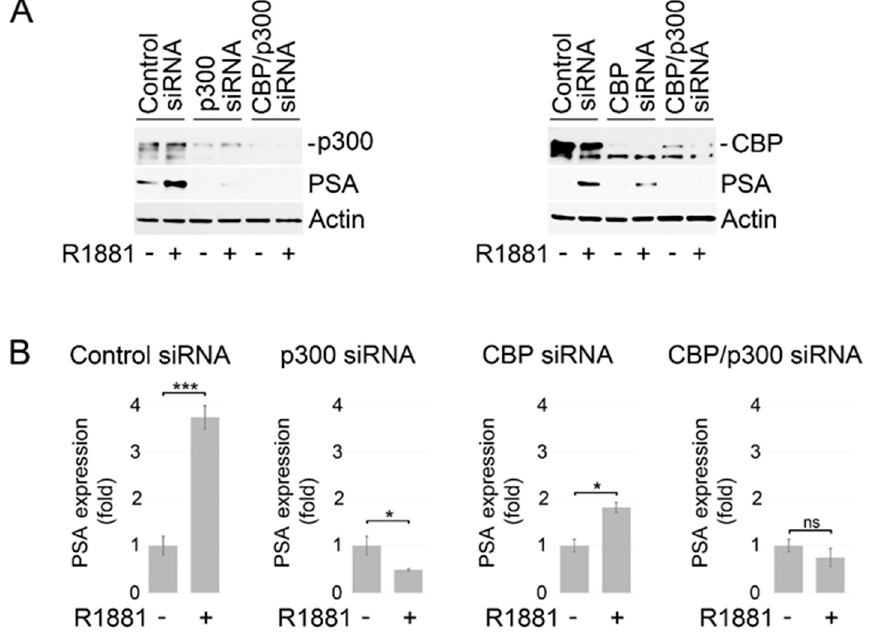
Figure 3. Knockdown of p300 and CBP inhibits AR signaling. ( A ) Analysis of p300, CBP, and PSA protein expression in LNCaP cells carrying the separate or combined p300 and CBP knockdowns.